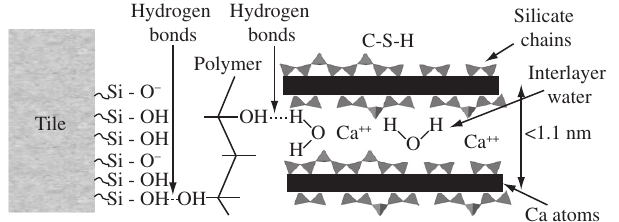
Figure 9. Schematic representation of nanostructured model for hybrid in- terface formation between porcelain tile and PVA modified mortar according to 27 (not in scale).